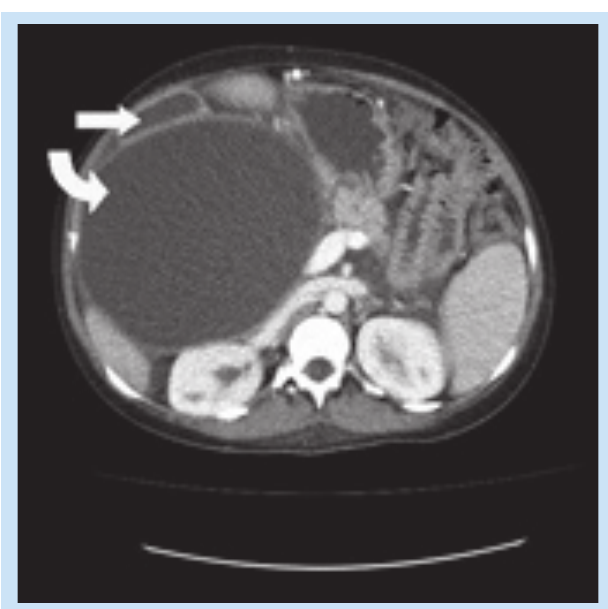
Fig. 2. Axial CT abdomen demonstrates the choledochal cyst located in the right hemi-abdomen (curved arrow) The gall bladder is indicated with a straight